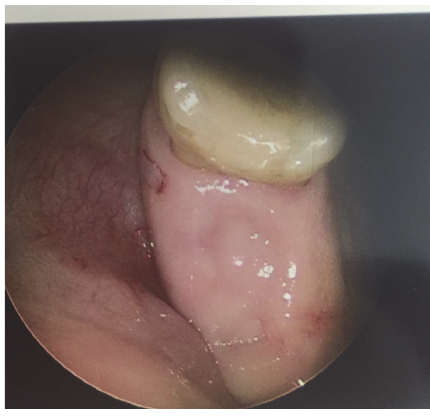
Figure 2: Intraoperative palpation of the dental extraction site revealing no opening into the maxillary sinus (oroantral fistula).